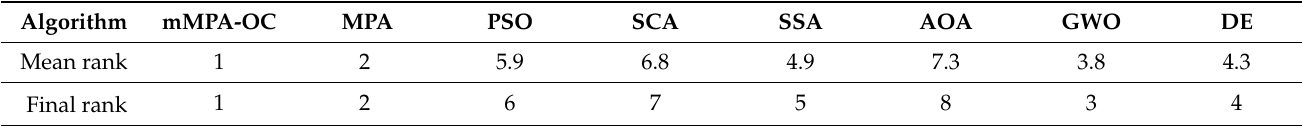
Table 18. Average ranking of the Friedman test on